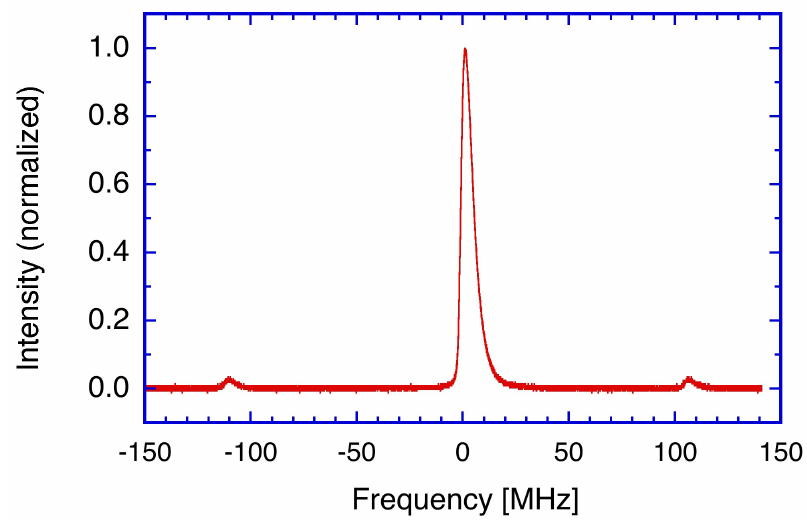
Figure 2. Fabry–Perot scan of the G ring cavity. At a measured output power of approximately 40 nW, additional longitudinal laser modes appear at a frequency of 6 times the free spectral range (FSR) away from the dominant mode on each